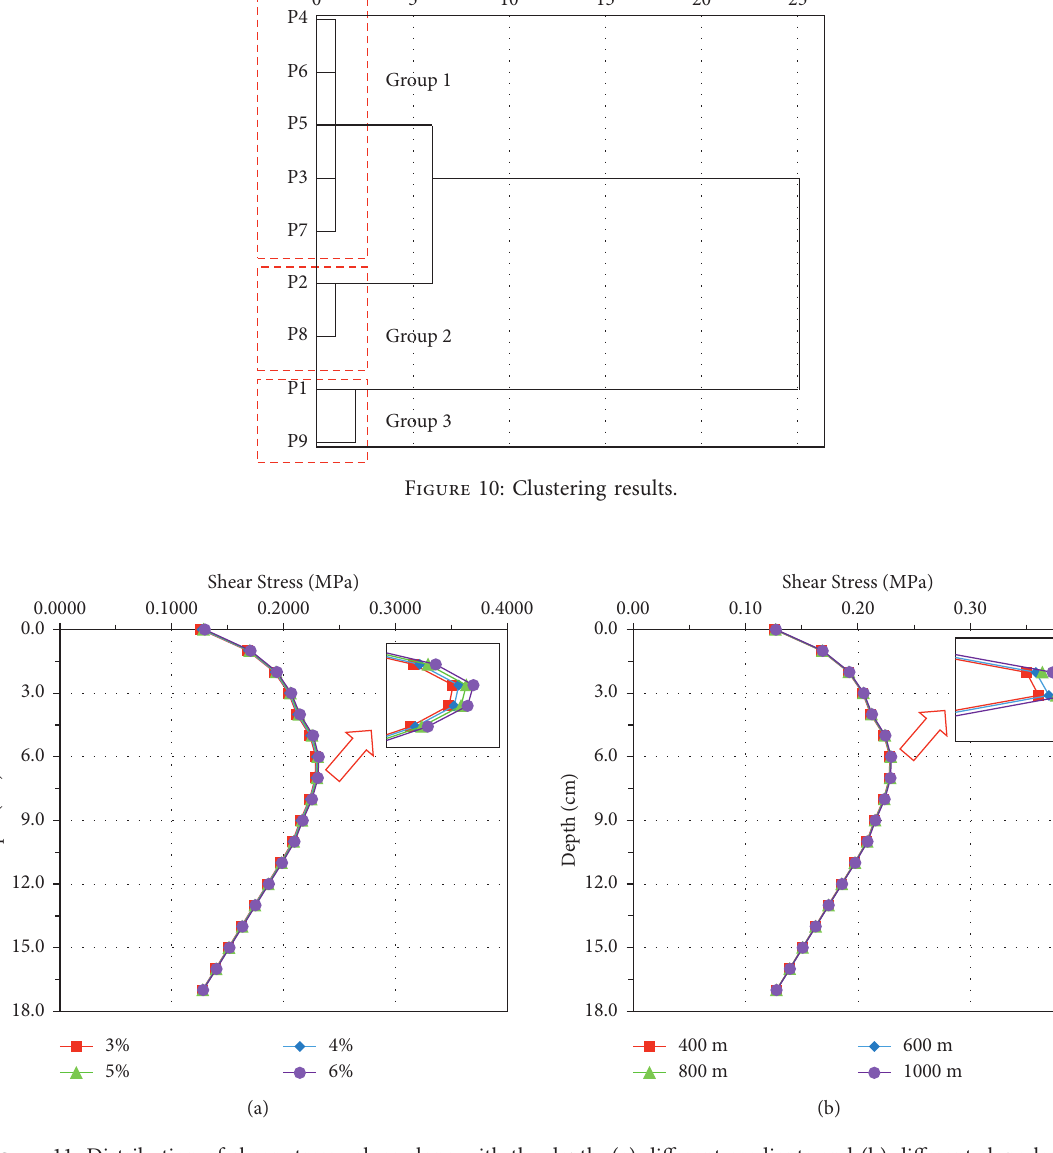
Figure 11: Distribution of shear stress values along with the depth: (a) different gradients and (b) different slope